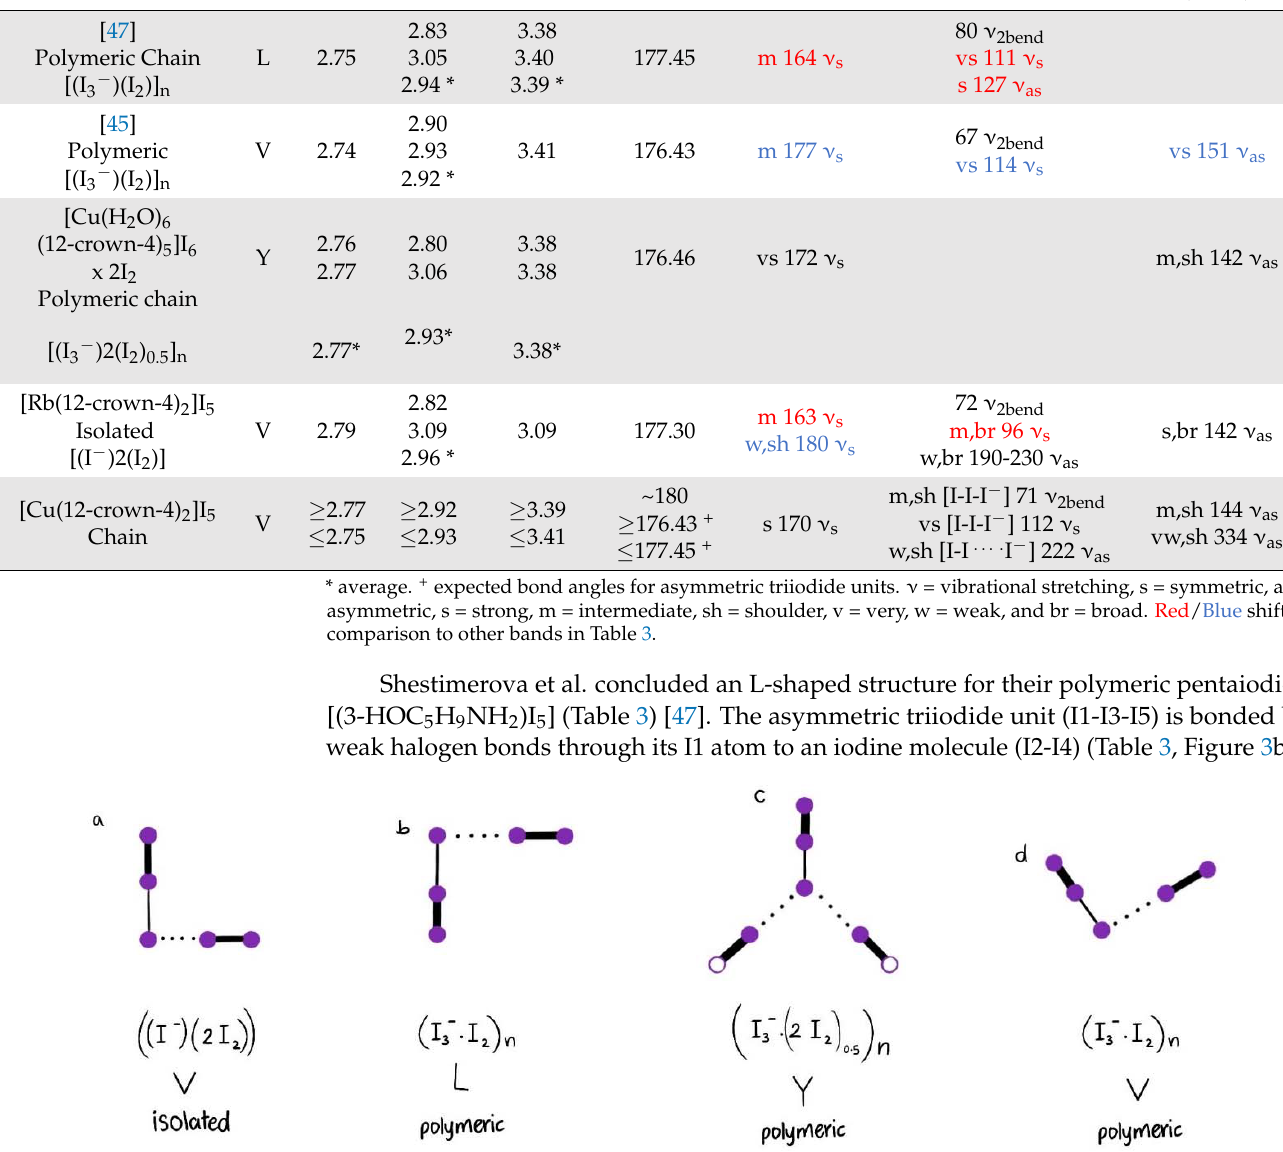
Figure 3. Comparative analysis of pentaiodides. ( a ) [Rb(12 ‐ crown ‐ 4) 2 ]I 5 [49]; ( b ) [(3 ‐ HOC 5 H 9 NH 2 )I 5 ] [47]; ( c ) [Cu(H 2 O) 6 (12 ‐ crown ‐ 4) 5 ]I 6 x 2I 2 [50]; ( d ) [(C 10 H 16 N 2 ) [I 3 ] 2 ∙ I 2 ] [45]. ( c ) [Cu(H 2 O) 6 (12-crown-4) 5 ]I 6 x 2I 2 [50]; ( d ) [(C 10 H 16 N 2 ) [I 3 ] 2 · I 2 ]